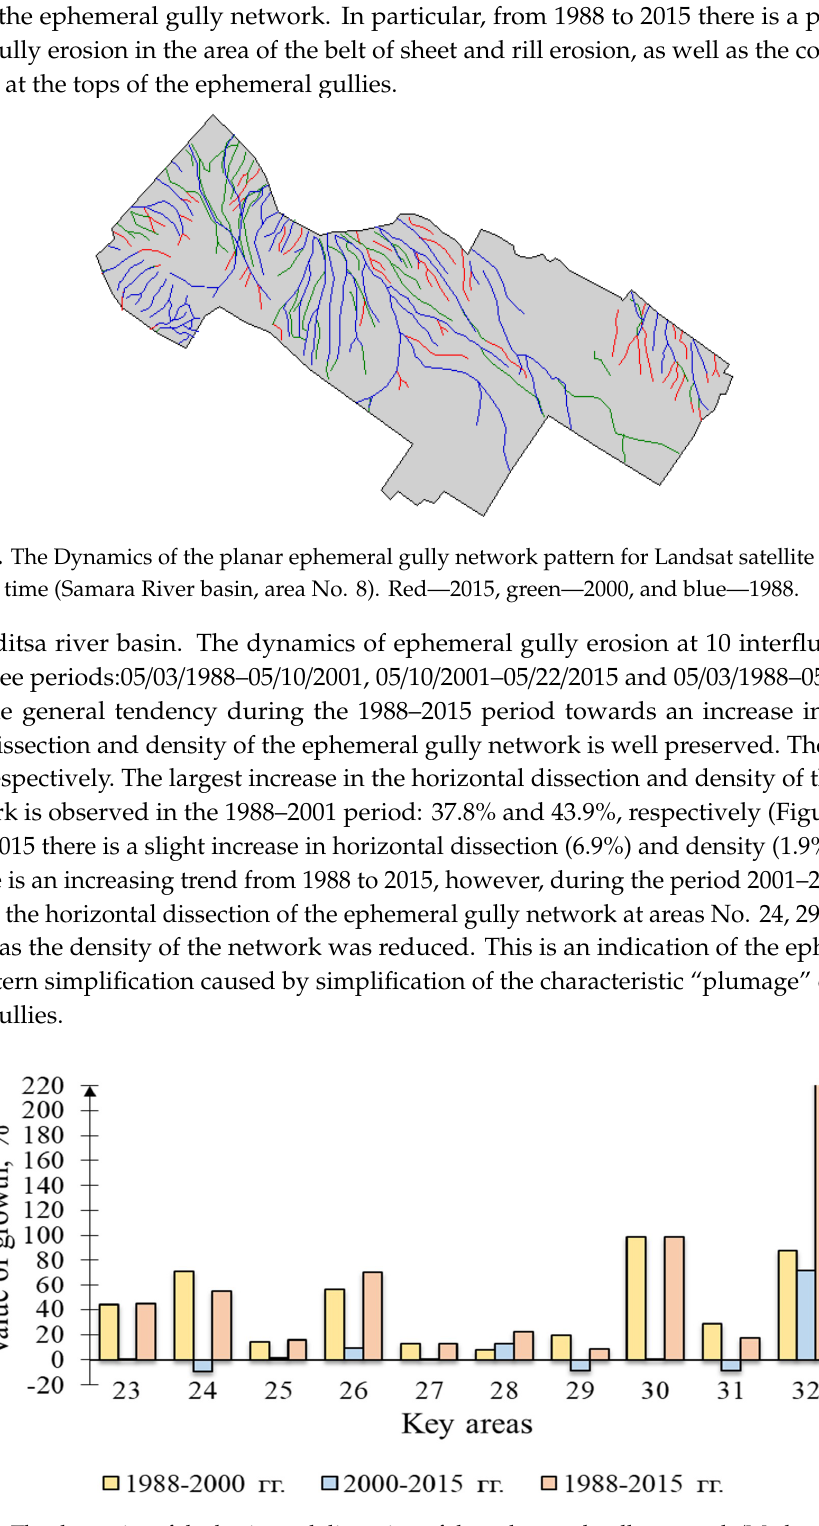
Figure 10. The density dynamics of the ephemeral gully network (Medveditsa river basin) for the periods 1988–2000, 2000–2015 and from 1988 to 2015. Mesha river basin. In order to assess the dynamic pattern 7 (1 to 7) key areas were selected for the period from 9 May 1988 to 29 April 2016. Intermediate images of the 2000s could not be selected due to their low quality. It can be noticed that from 1988 to 2016 the average horizontal dissection and density have increased by 5.1% and 9.8% respectively. The maximum values of the horizontal dissection and density of the ephemeral gully network are observed in the area No. 1. Negative values are found in areas No. 3, 4, 7 (Figures 11 and 12).